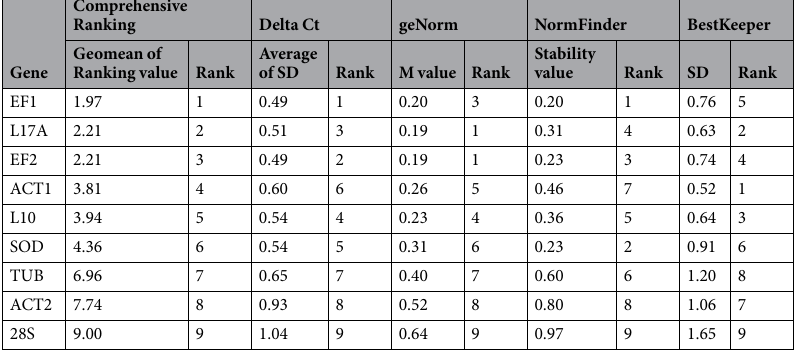
Table 3. Stability of candidate reference genes under ascovirus-infected conditions in S. exigua across all